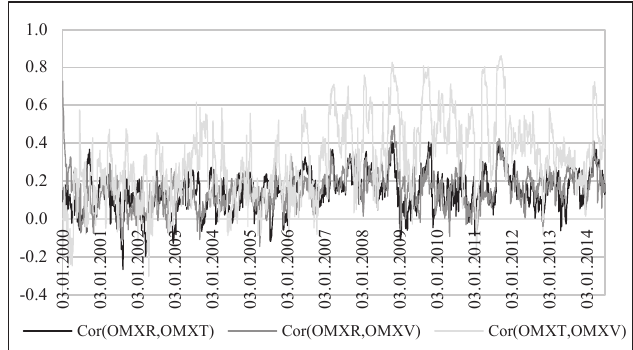
Fig. 1. Dynamic conditional correlation using DCC-GARCH (1,1) model (the author’s